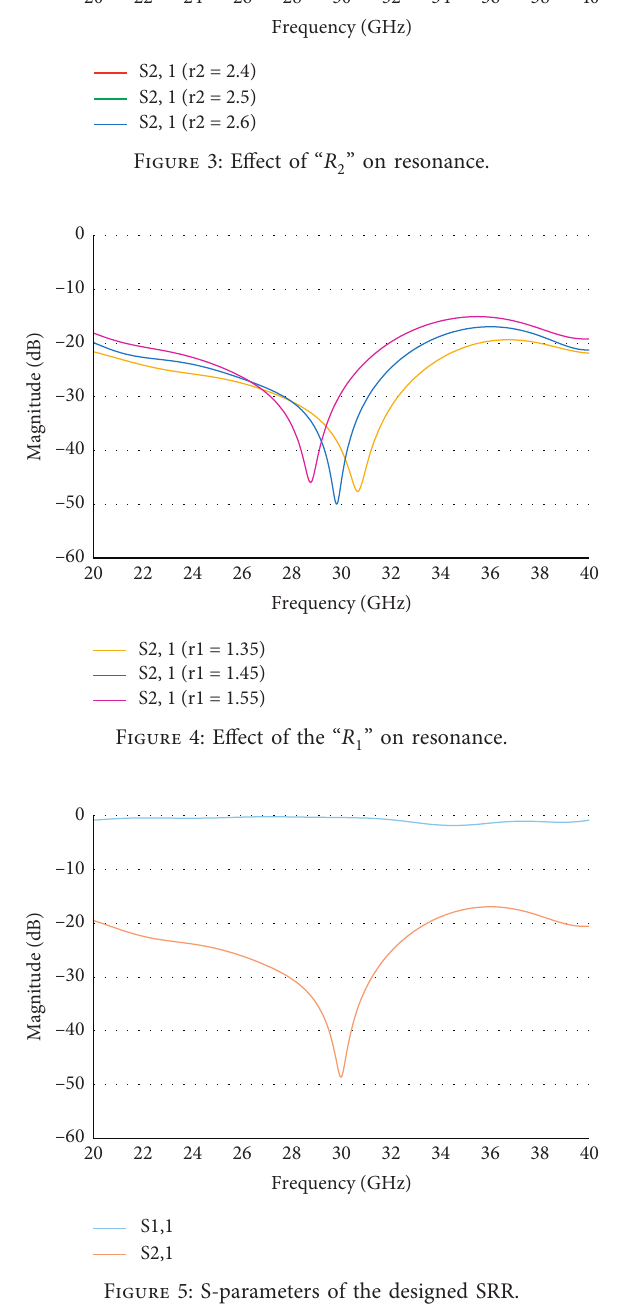
Figure 5: S-parameters of the designed